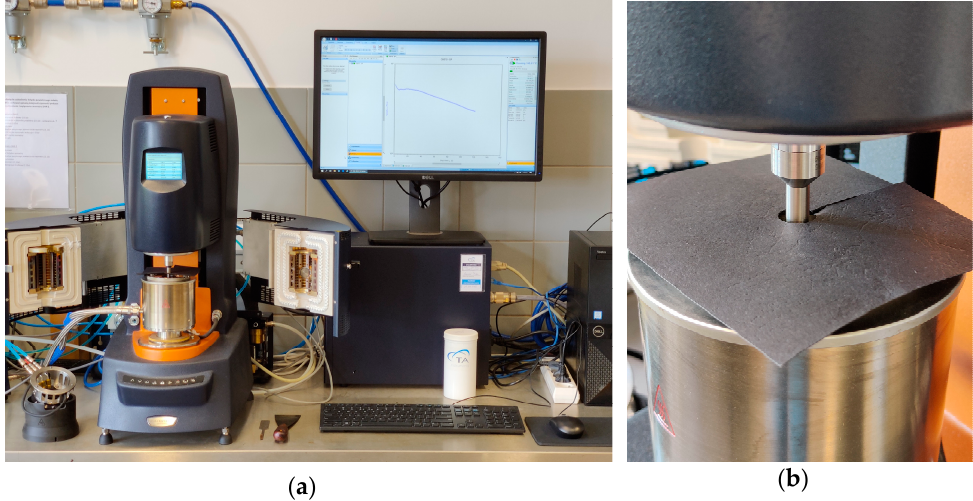
Figure 4. TA Instruments DHR-2 rheometer: ( a ) the device; ( b ) a protecting cover in case of sponta- neous bursts of foamed bitumen.